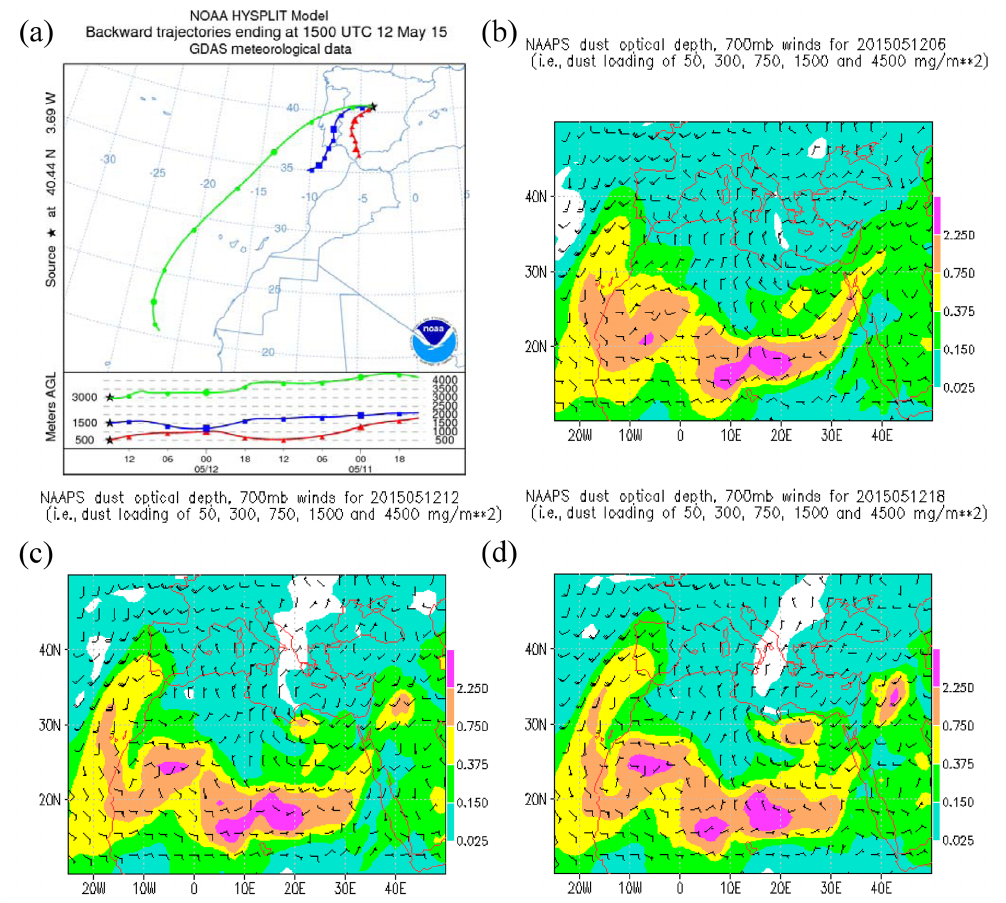
Figure 9. Air mass pathway analysis: (a) 48h back-trajectories arriving in Madrid at 15:00UTC and NAAPS modeled dust optical depth at (b) 06:00, (c) 12:00 and (d) 18:00UTC on 12 May 2015 from